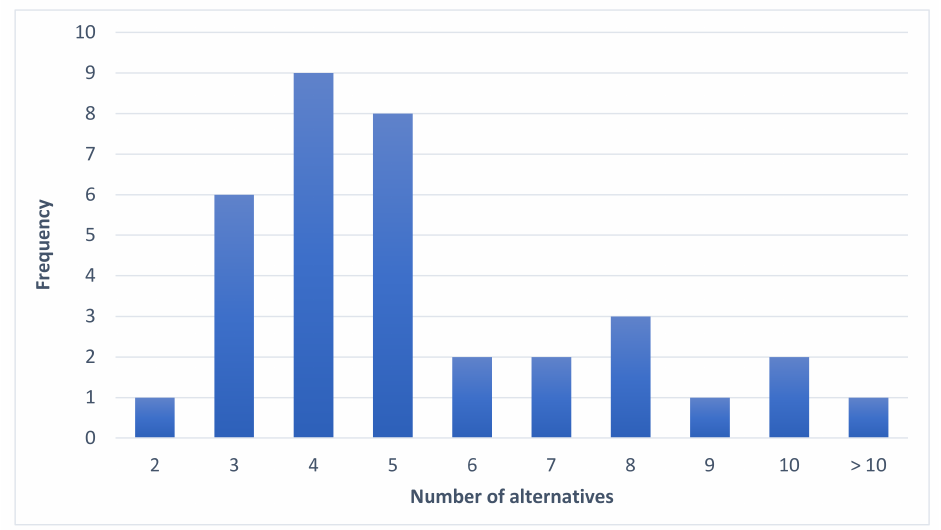
Figure 4. Distribution of the number of alternatives in the reviewed